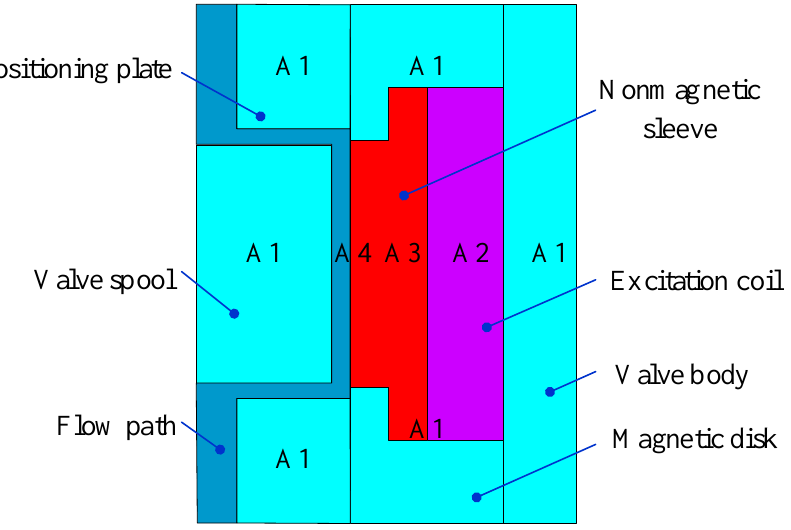
Figure 7. Geometry model of radial MR valve.